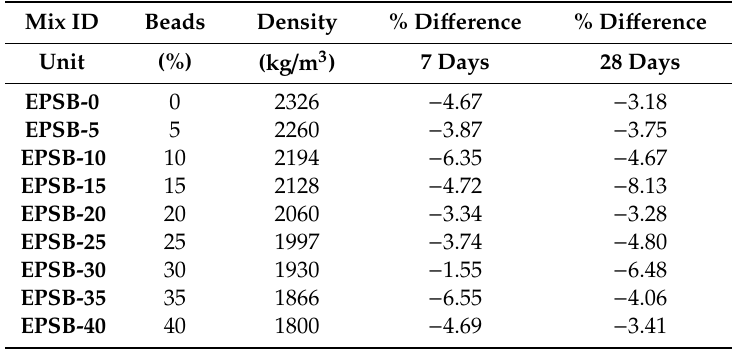
Table 9. Strength di ff erence b / w destructive and non-destructive